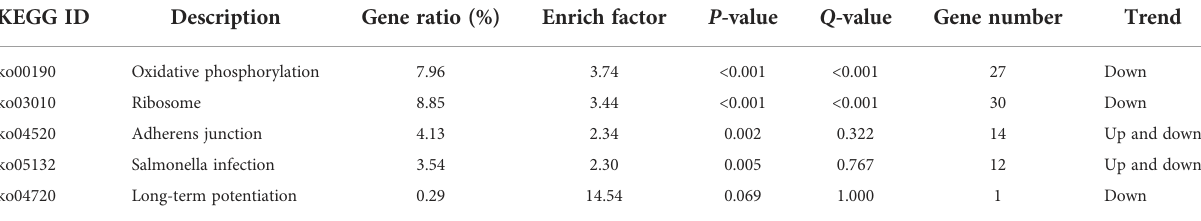
TABLE 5 The top 5 KEGG pathway enrichment analysis of